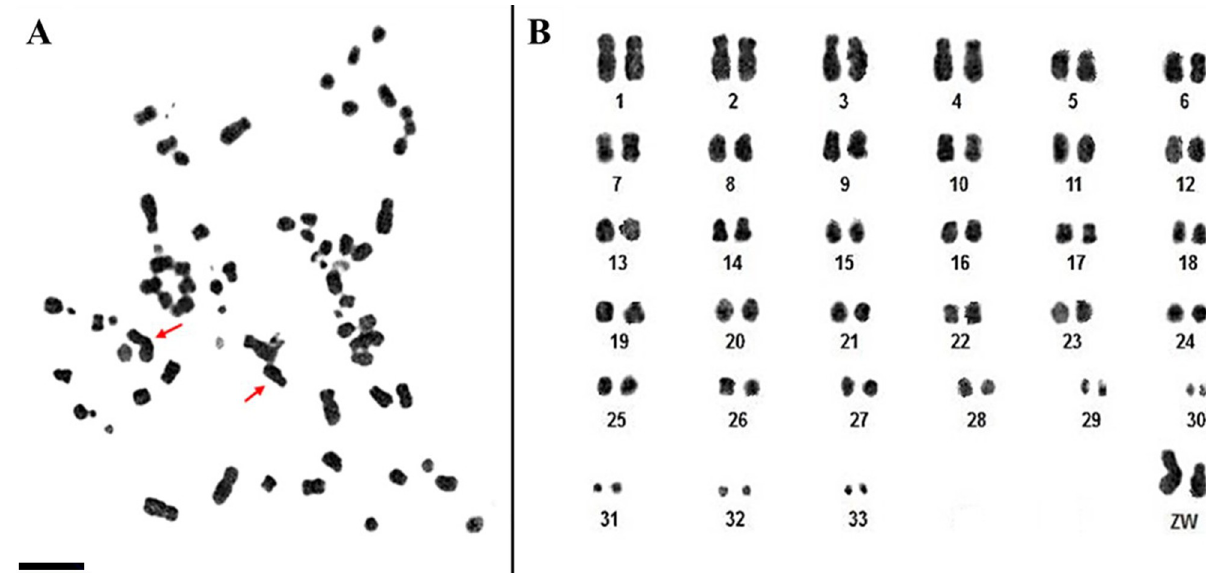
Fig 1. Metaphase (A) and karyotype (B) of S . tyrannus with 2n = 68, obtained with Giemsa conventional staining. The red arrows in (A) indicate the sex chromosomes. Scale bar: 5 μ m.